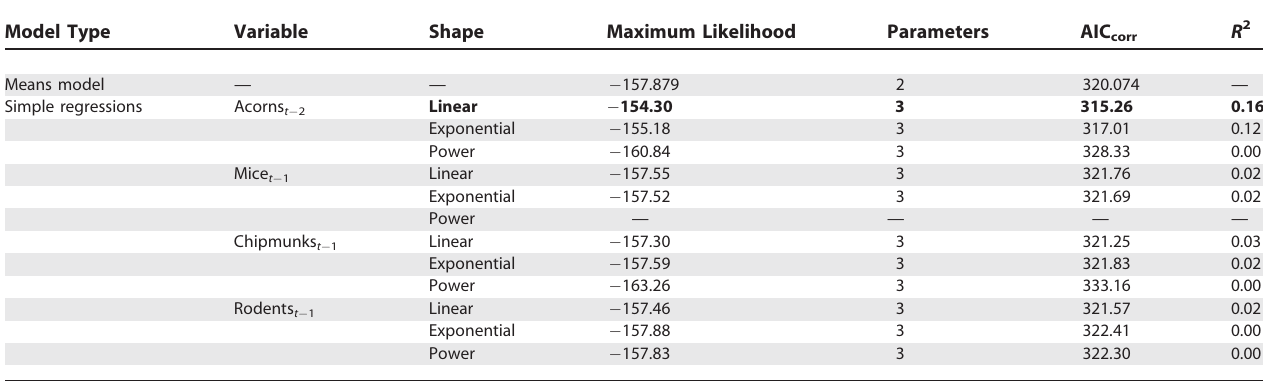
Table 4. Model Comparison Statistics for Independent Variables Potentially Influencing NIP Based on the Subset of Plot-Years for Which All Independent Variables Were Estimated (42 Plot